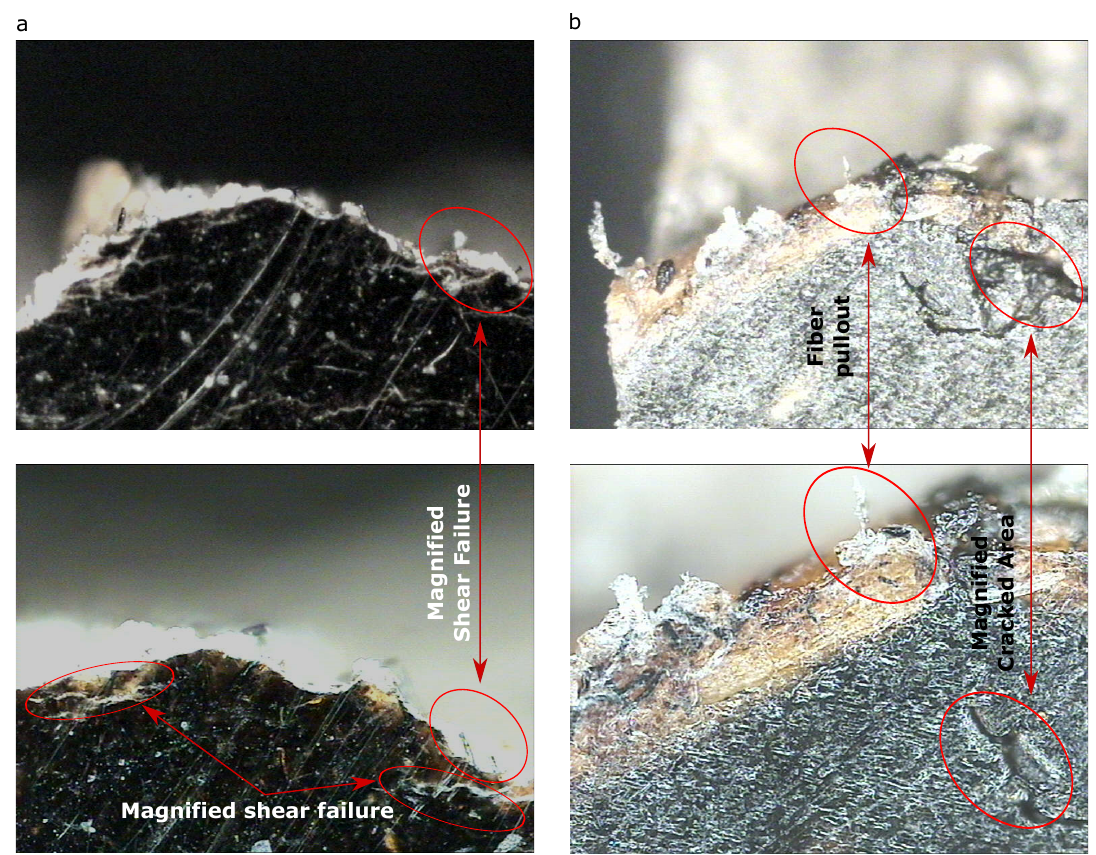
Figure 11. Representative samples (30% of filler addition) that show the failed material with 20 × (top) and 50 × magnification (bottom) taken after the tensile test and from the fracture surface for ( a ) PP/CF composites, and ( b ) PVC/CF